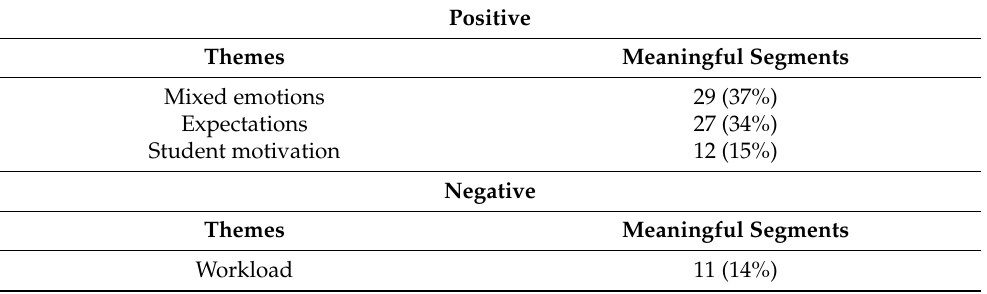
Table 3. Themes and meaningful segments from the